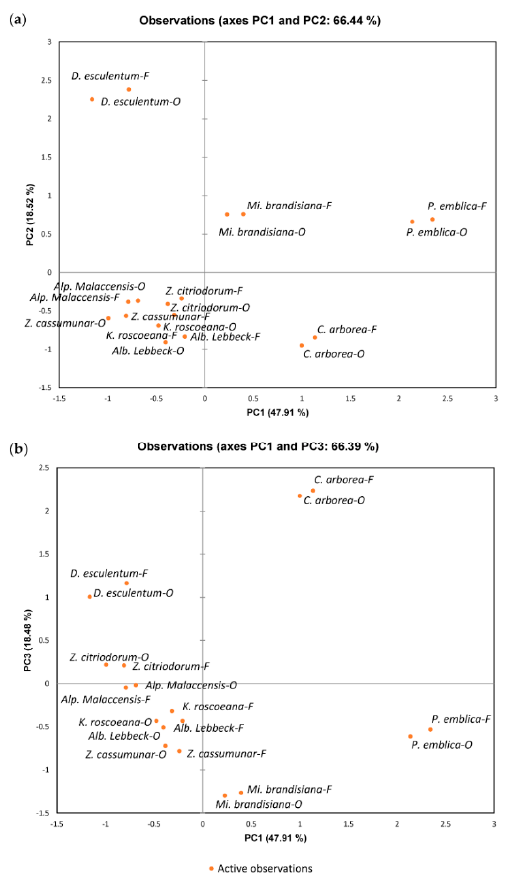
Figure 1. Principal component analysis (PCA) from mean values of tested variables including TPCs, antioxidant activities (determined by 2,2-diphenyl-1-picrylhydrazyl (DPPH) radical-scavenging, ferric reducing antioxidant power (FRAP), and oxygen radical antioxidant capacity (ORAC) assays), enzyme-inhibitory activities (against α -amylase, α -glucosidase, lipase, acetylcholinesterase (AChE), butyrylcholinesterase (BchE), and β -secretase (BACE-1)), and anti-glycation activities (methylglyoxal (MG) and sugar induction) (freeze-dried and oven-dried plant extracts): ( a ) observations between PC1 and PC2; ( b ) observations between PC1 and PC3.